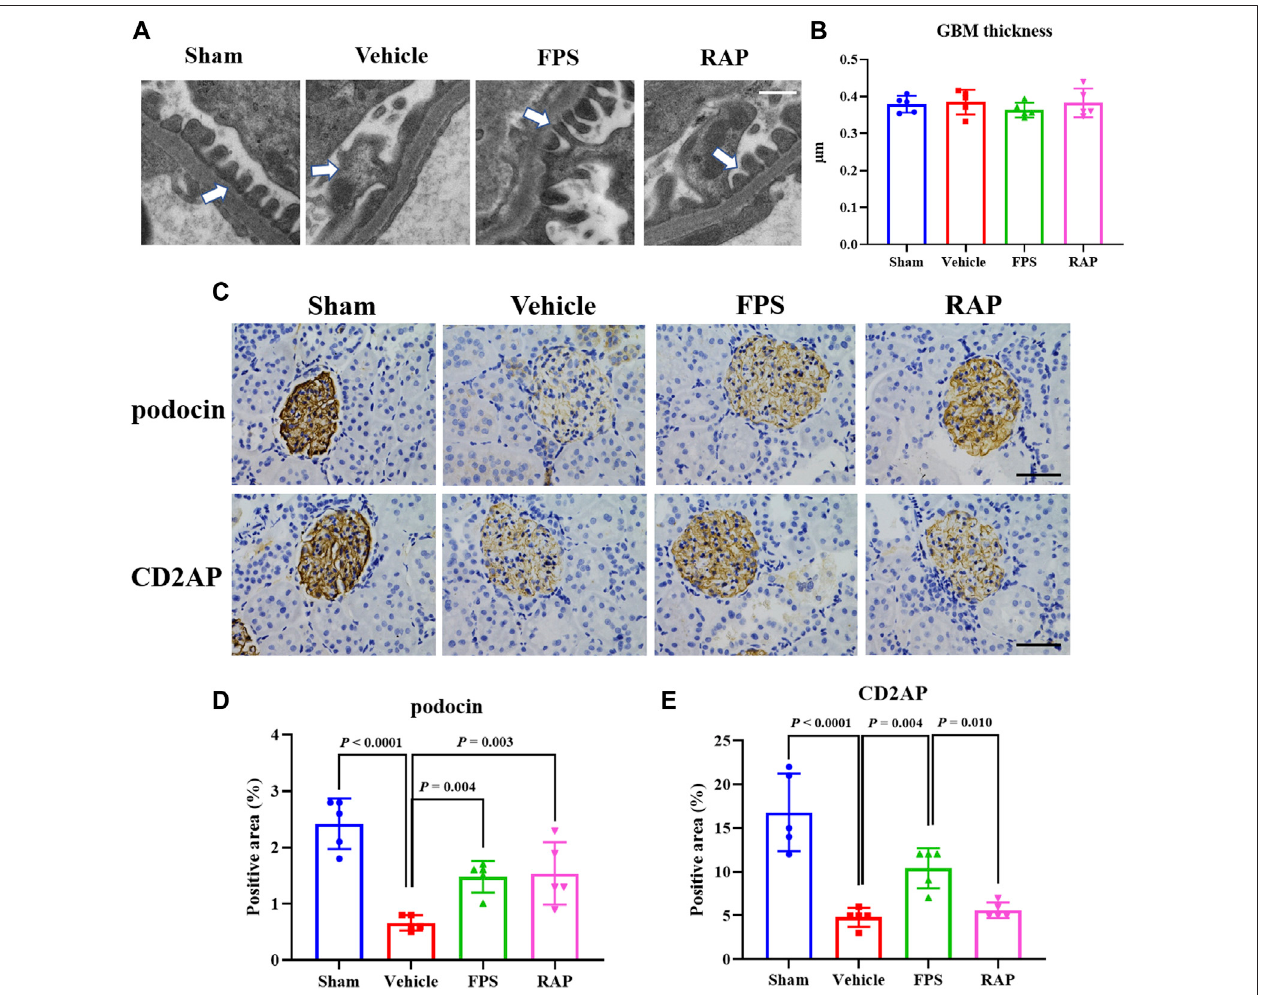
FIGURE 4 | Effects of FPS and RAP on foot process form, GBM thickness, and the expression characteristics of podocin and CD2AP in vivo . (A) The ultra- microstructure of foot process form and GBM (×11,500). Scale bar = 500 nm. (B) The GBM thickness. (C) The immunostaining of podocyte and CD2AP in glomeruli (×400). Scale bar = 50 μ m. (D,E) The positive area of podocin and CD2AP in glomeruli. The data are expressed as the mean ± SD.